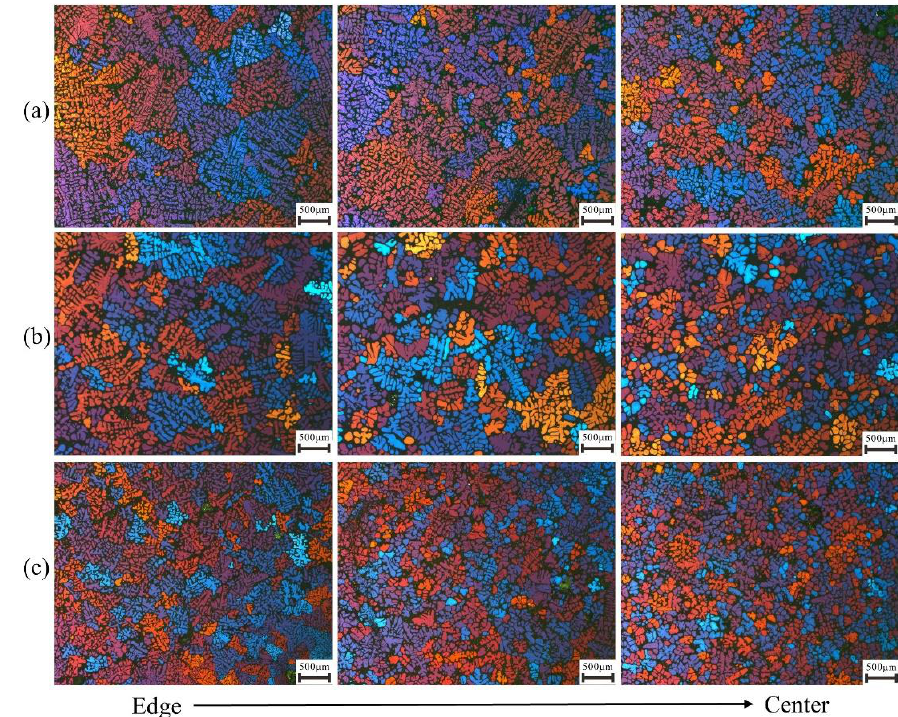
Figure 7. Experimental results about the microstructures from edge to center in slurries made by crucibles with different temperature gradients, ( a ) 0.230 °C/mm, ( b ) 0.442 °C/mm and ( c ) 0.657 °C/mm.